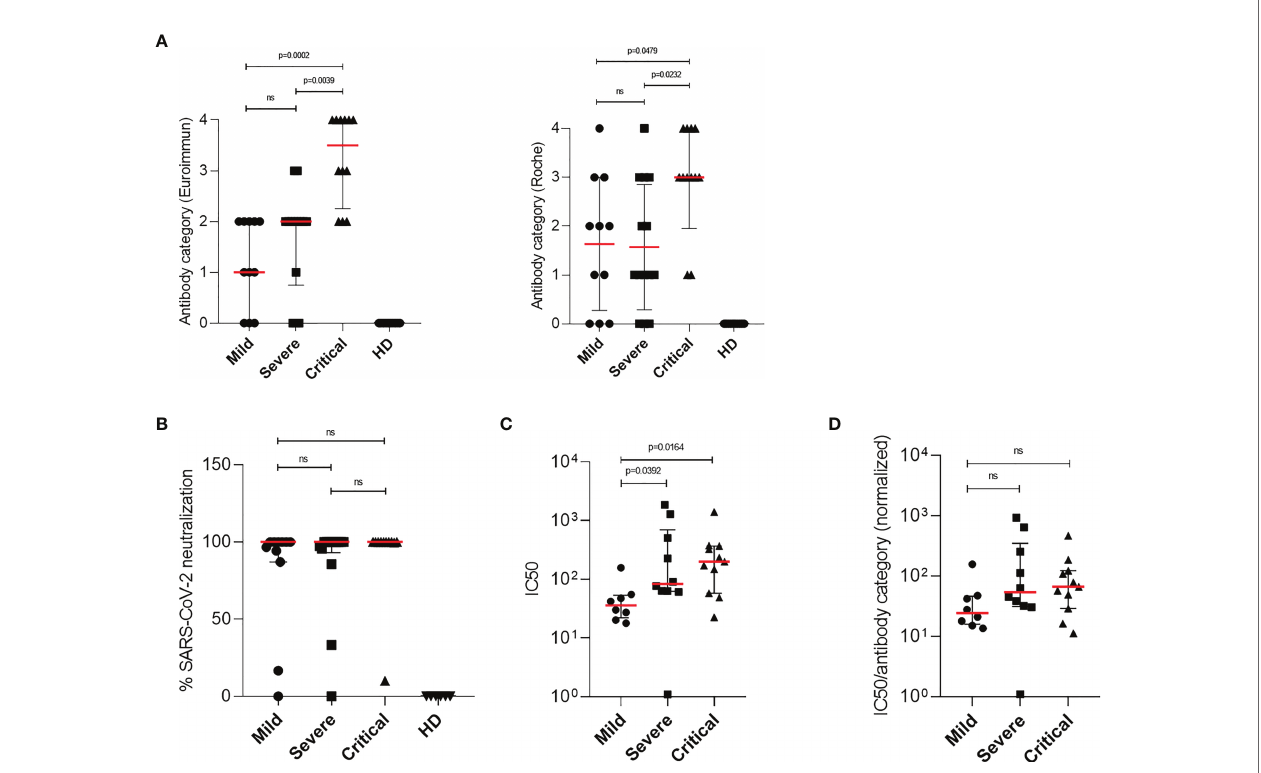
FIGURE 4 | Detection of SARS-CoV-2-speci fi c antibodies and characterization of the neutralizing ability by patient antibodies. Titers of SARS-CoV-2-speci fi c IgG antibodies were determined from plasma samples of COVID-19 patients. (A) Antibodies ratios were grouped in four categories (quartiles) and assigned to an antibody category (1 = low, 2 = medium low, 3 = medium high and 4 = high IgG titer). Antibody categories of all mild, severe and critically ill patients and healthy donors, analyzed by the Euroimmun (left) or Roche test kit, are shown. (B) Neutralization plaque assays were performed by 1 h incubation of SARS-CoV-2 strains and 1:10 diluted plasma samples from COVID-19 patients or culture medium as control. After incubation plasma – virus mix was ultracentrifuged and resuspended in reduced culture medium and used for inoculation of VeroE6/TMPRSS2 cells. After 1 h inoculation, solution was removed and cells were overlayed with culture medium containing agarose. After 3 days plaques were counted and plaque forming units per ml (PFU/ml) were calculated. Neutralizing ability of patients plasma samples were assessed by the reduction of PFU/ml and compared to medium-treated virus controls. Percentages of SARS-CoV-2 neutralization using a 1:10 dilution of plasma samples from mild, severe and critical COVID-19 patients are shown. (C) Neutralization plaque assay over a 1:10 to 1:2,500 dilution range was performed using only IgG positive plasma samples of COVID-19 patients. To determine the neutralizing capacity half-maximal neutralizing titer values (IC50 values) from neutralization curves were calculated using four-parameter nonlinear regression. IC50 values from mild (n = 5), severe (n = 9) and critical patients (n = 11) are illustrated. (D) Normalized IC50 values were calculated using the IC50 values from neutralization curves and previously established SARS-CoV-2-speci fi c IgG antibody category from the Euroimmun test kit, due to its speci fi city towards the viral spike protein. Normalized IC50 values from mild (n = 5), severe (n = 9) and critical (n = 11) COVID-19 patients are shown. Median levels of antibody categories, normalization ability, IC50 and normalized IC50 are represented as red lines and error bars represent interquartile range. Statistical differences were determined using Kruskal – Wallis and Dunn ’ s post tests. ns, not signi fi